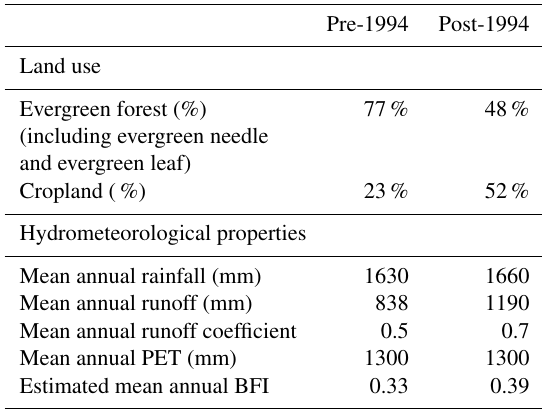
Table 1. Study catchment